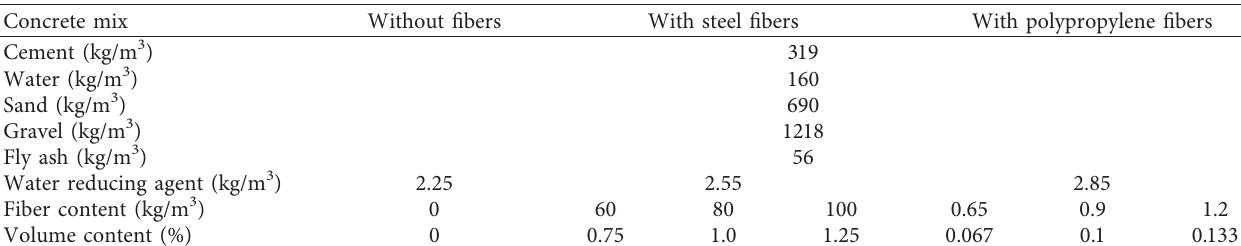
Figure 1: Exterior of fiber: (a) corrugated steel fibers; (b) polypropylene fibers. Table 1: Mix proportion for